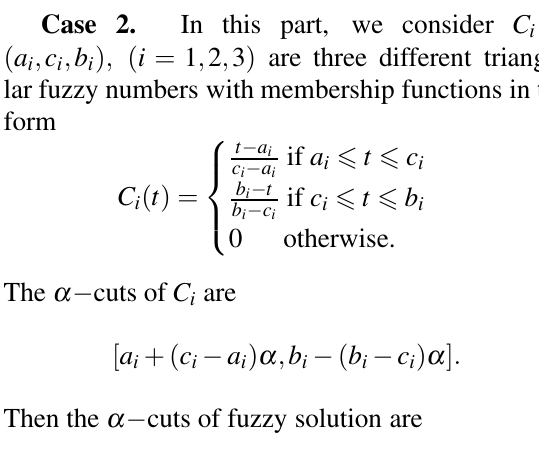
Fig. 8. The 2D graphs of some α − cuts of fuzzy solution.